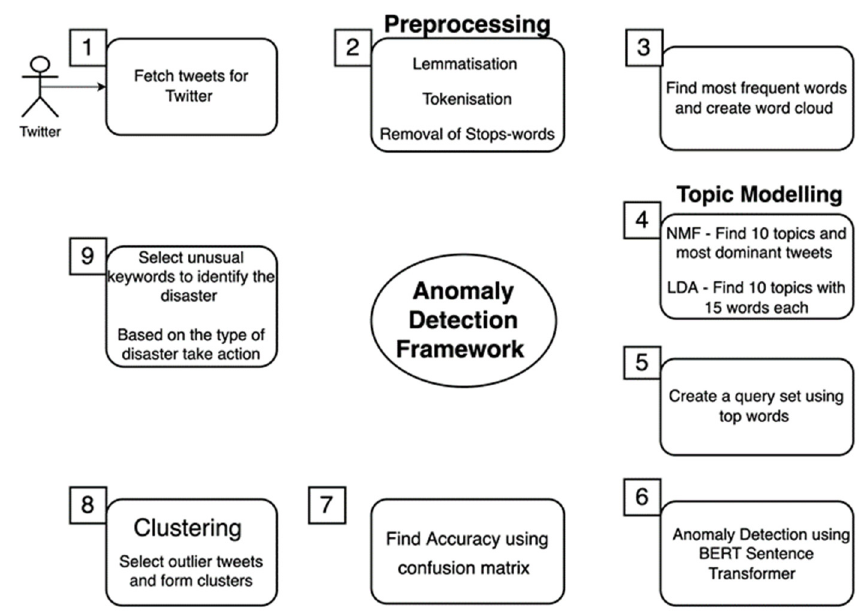
Figure 1. Proposed anomaly detection